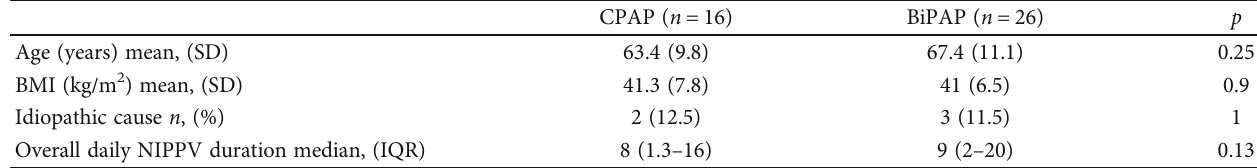
Table 4: Association between discharge instrumental respiratory therapy and age, BMI, and overall daily NIPPV duration.